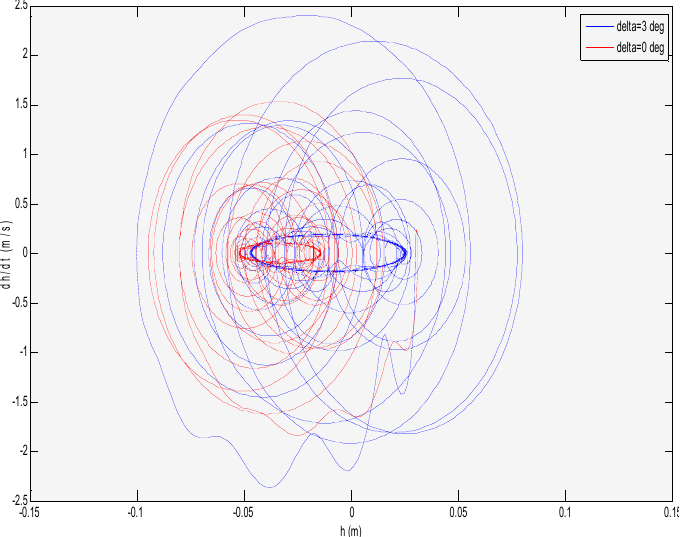
Figure 28. The state space response of beta without freeplay and with 2 ◦ freeplay. (In flutter speed).